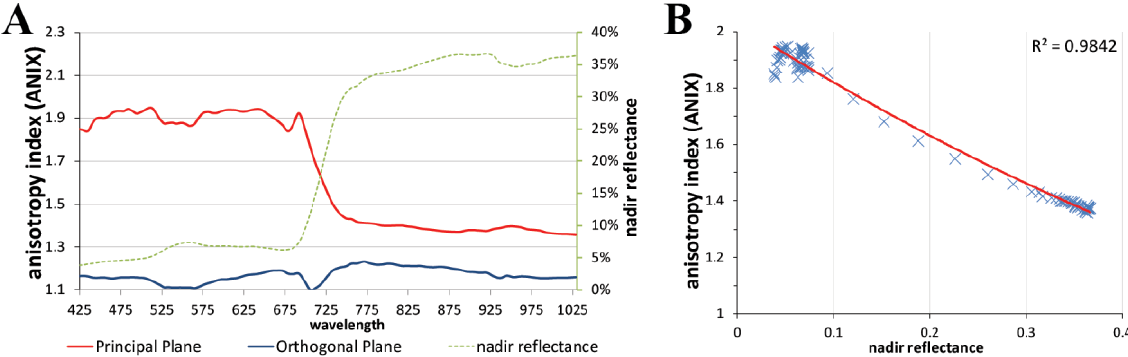
Figure 12. ( A ) Anisotropy index (ANIX) versus wavelength in the solar principal and orthogonal plane; ( B ) ANIX versus nadir reflectance showing strong linkage (higher degree of reflectance in nadir view position = lower degree of reflectance anisotropy).